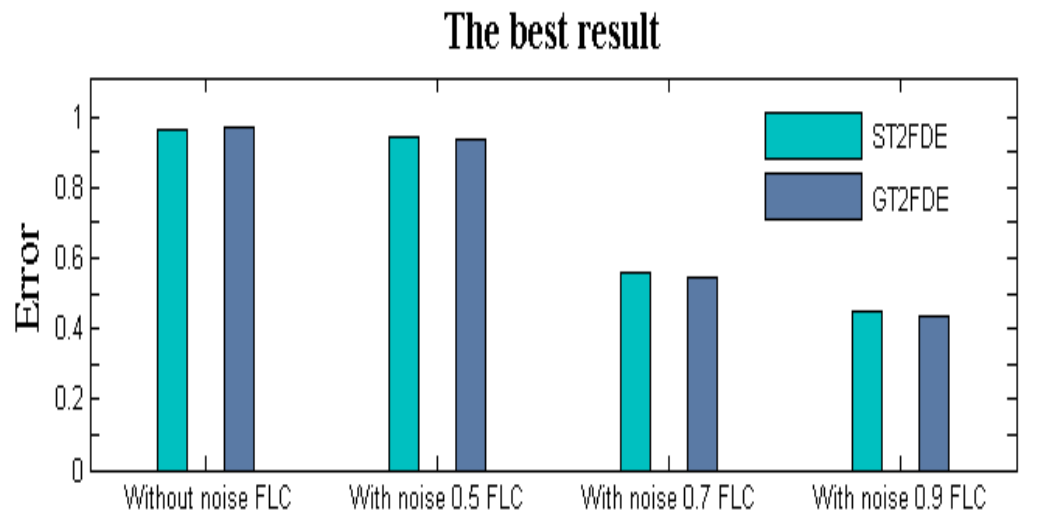
Figure 22. Comparison of the best results between ST2FDE and GT2FDE without noise and with different noise levels.